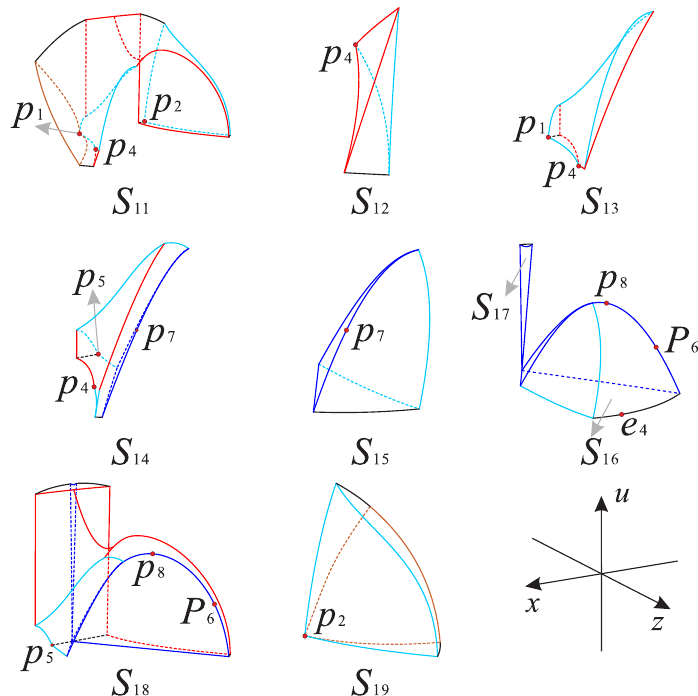
Figure 25. The nine subregions inside the region S 1 of the Poincaré ball.